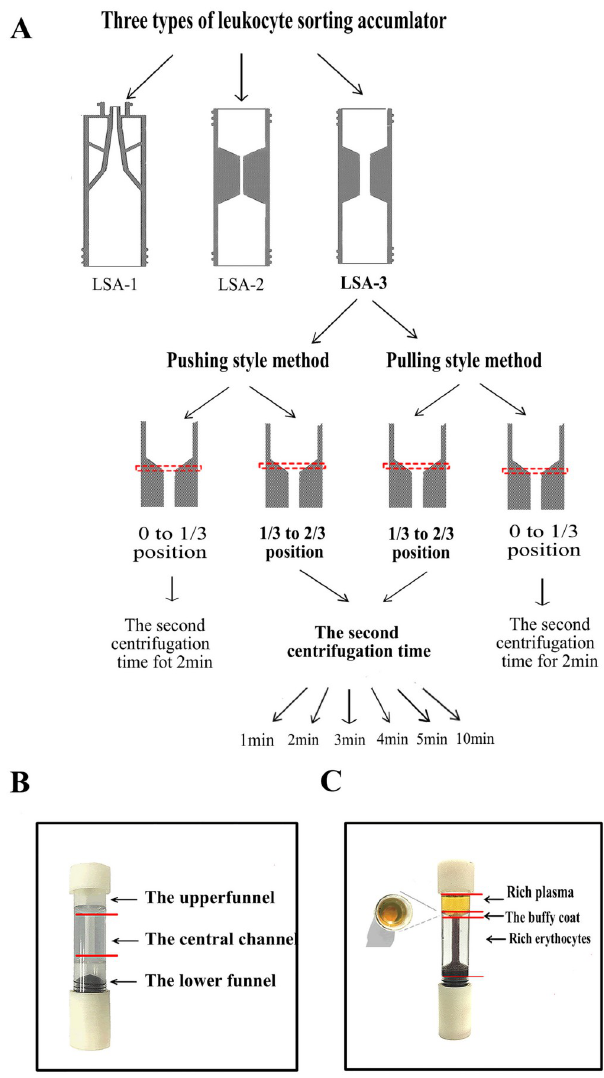
Fig 4. Schematic illustration of the working principles of the LSAs. (A) Flow-process diagram for enrichment of leukocytes by the LSAs models. The position of buffy coat in the upper funnel is identified by the red rectangle. (B) 3D printed LSA-3 including the upper funnel, the central channel and the lower funnel. (C) Whole blood separated by the cell density in three fractions: Rich platelets, the buffy coat and rich erythrocytes.